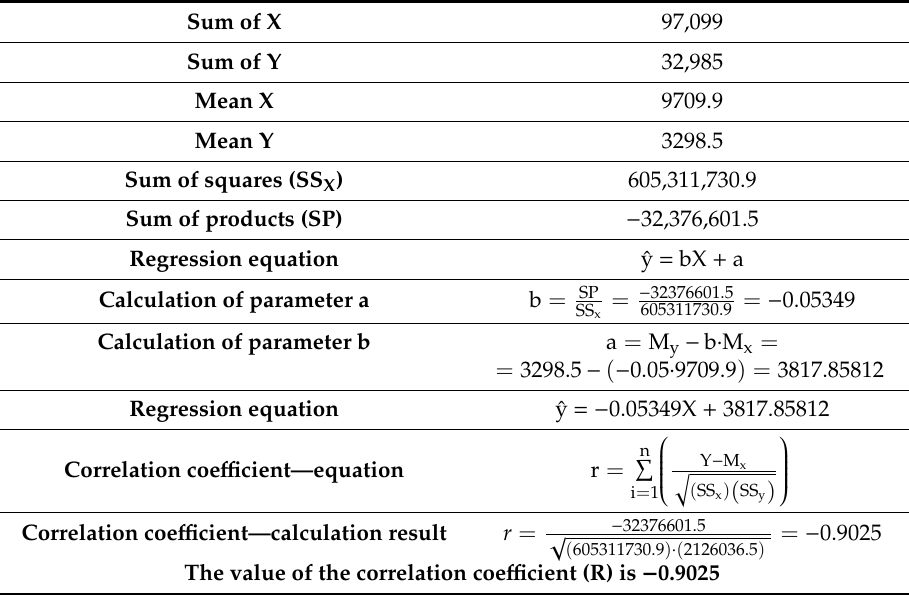
Table 2. Summary results of linear regression calculation.